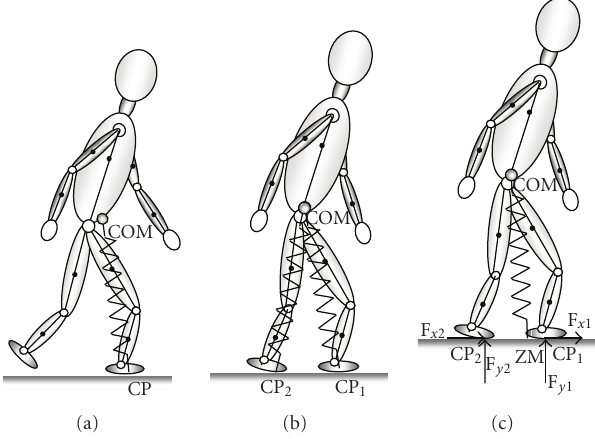
Figure 1: Mass and spring inverted pendulum walking gait representation: (a) single support, (b) double support represented by two springs, and (c) double support represented by a single spring.